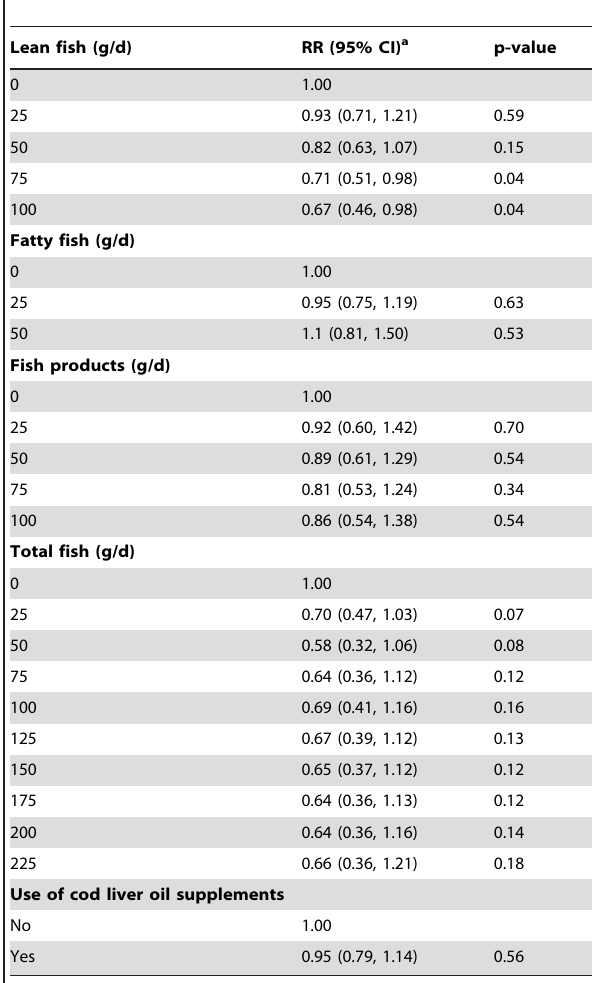
Table 3. Risk of T2DM in relation to fish consumption in the study population (n=